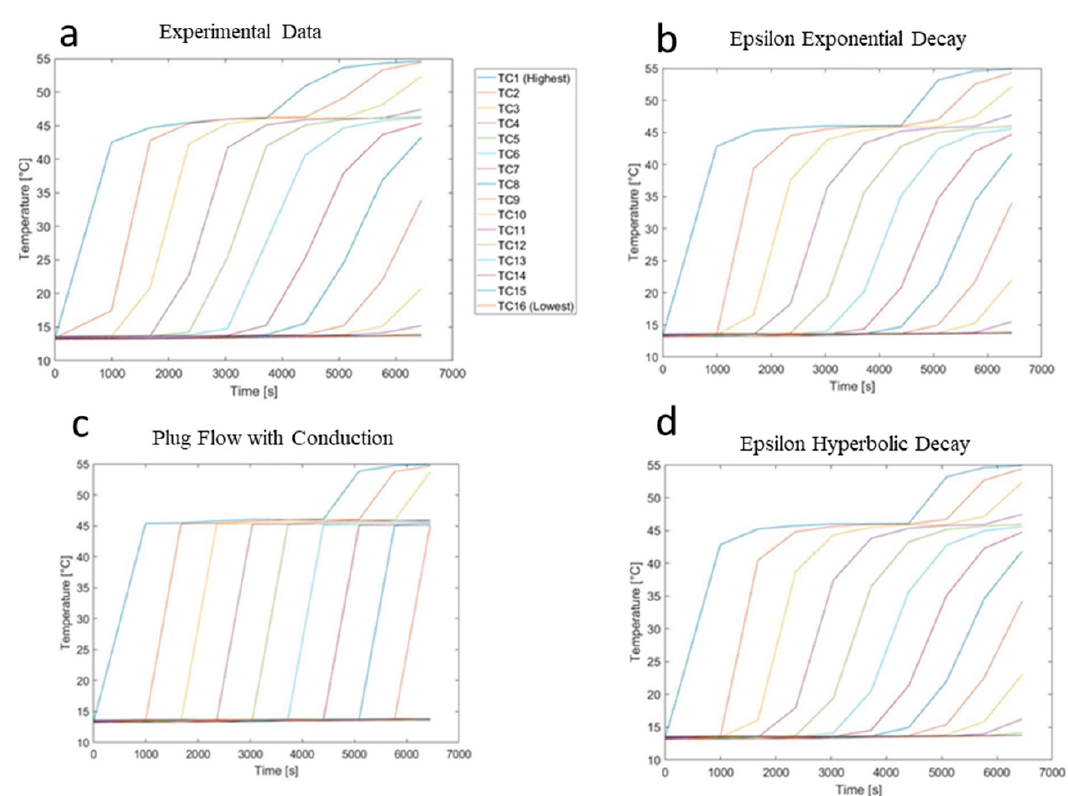
Figure 6. Two thermoclines were created by increasing the temperature of the water delivered to the tank for recharge by 5 °C. ( a ) Experimental data; ( b ) ε model using exponential decay; ( c ) plug-flow model with the inclusion of conduction in the water; and ( d ) ε model using hyperbolic decay.